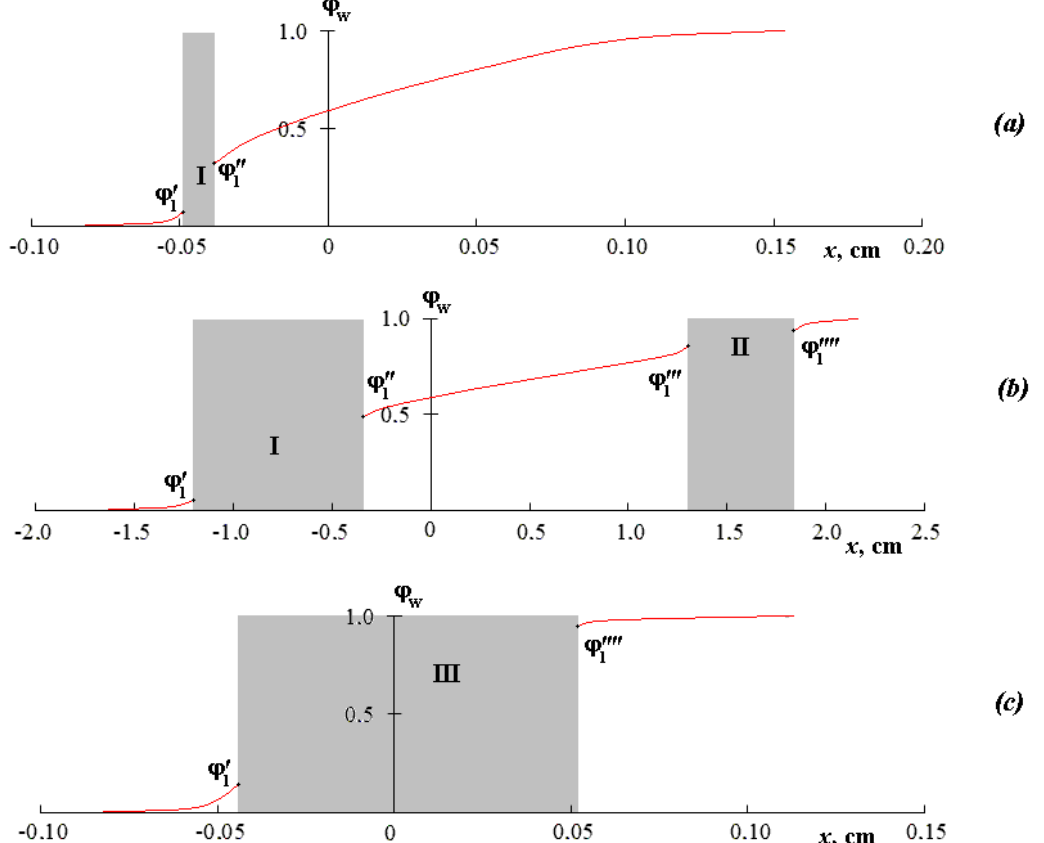
Figure 2. Concentration profiles of mixing PVME with water, obtained in the mode of the stepwise rise of temperature at ( a ) 22 ◦ C, ( b ) 22 ◦ C → 32 ◦ C, ( c ) 32 ◦ C → 35 ◦ C (see text for details). The interaction time of the components with a stepwise rise of temperature corresponds to ( a ) 85 min, ( b ) 370 min, and ( c ) 397 min from the beginning of the experiment.